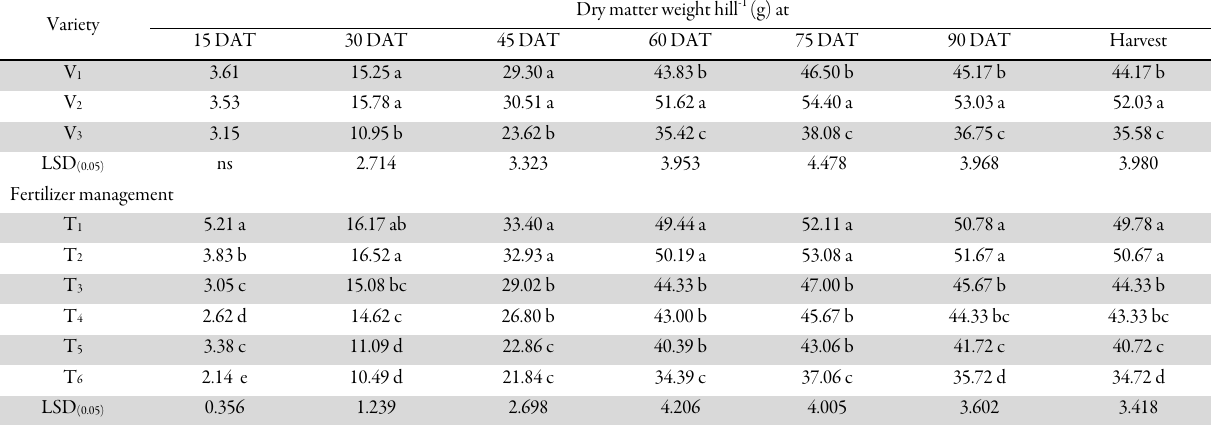
Table 2. Effect of varietal variation and fertilizer management on dry matter weight hill -1 of rice at different DAT